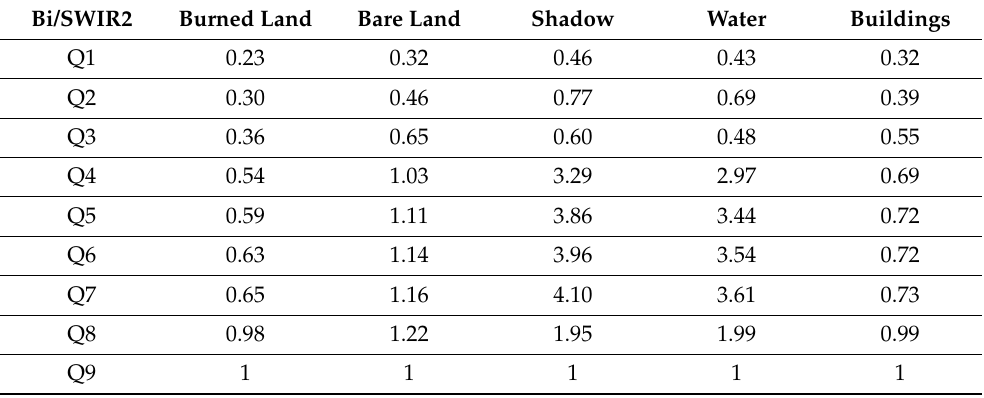
Table 4. Values of band ratios of most confused land covers (9 bands divided by the SWIR2 band). Bi/SWIR2 Burned Land Bare Land Shadow Water